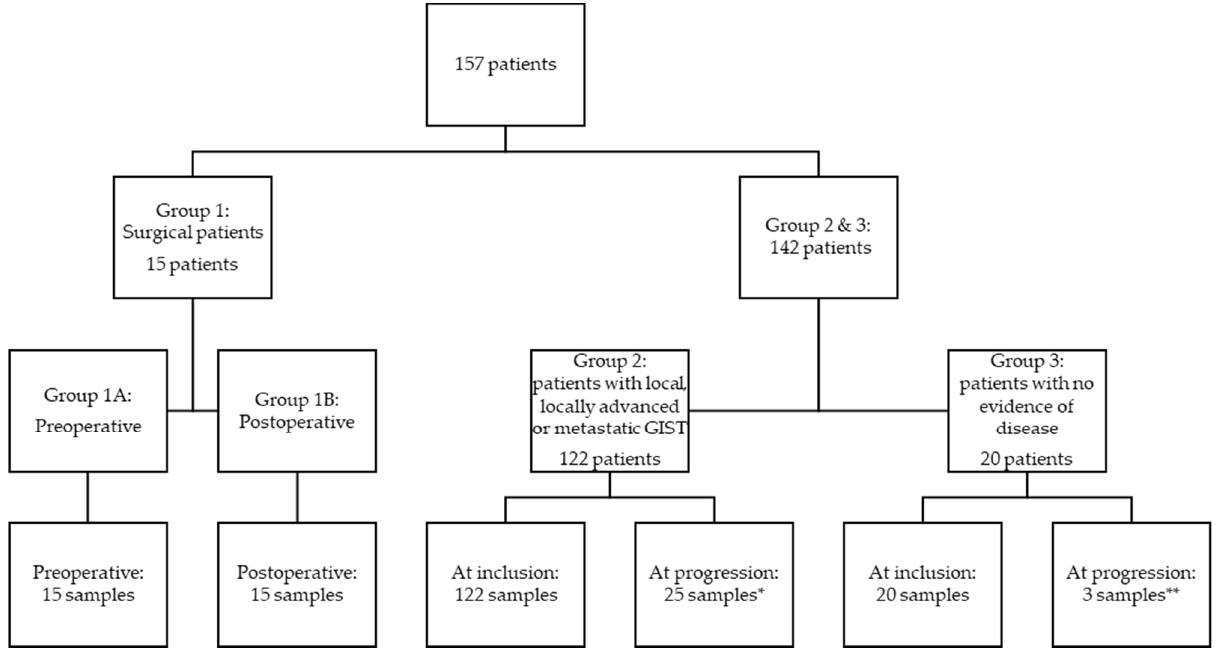
Figure 1. Flow chart of included patients. Group 1: patients with local disease who underwent radical surgery; group 2: patients with local, locally advanced, microscopic, or macroscopic metastatic disease, and group 3: patients without measurable disease (patients radically resected for localized GIST and in adjuvant treatment or patients in surveillance after completed adjuvant treatment). * Thirty-four patients progressed in total, but only 25 progression samples were available from 21 patients. ** Three patients progressed, and all three had a progression sample available.